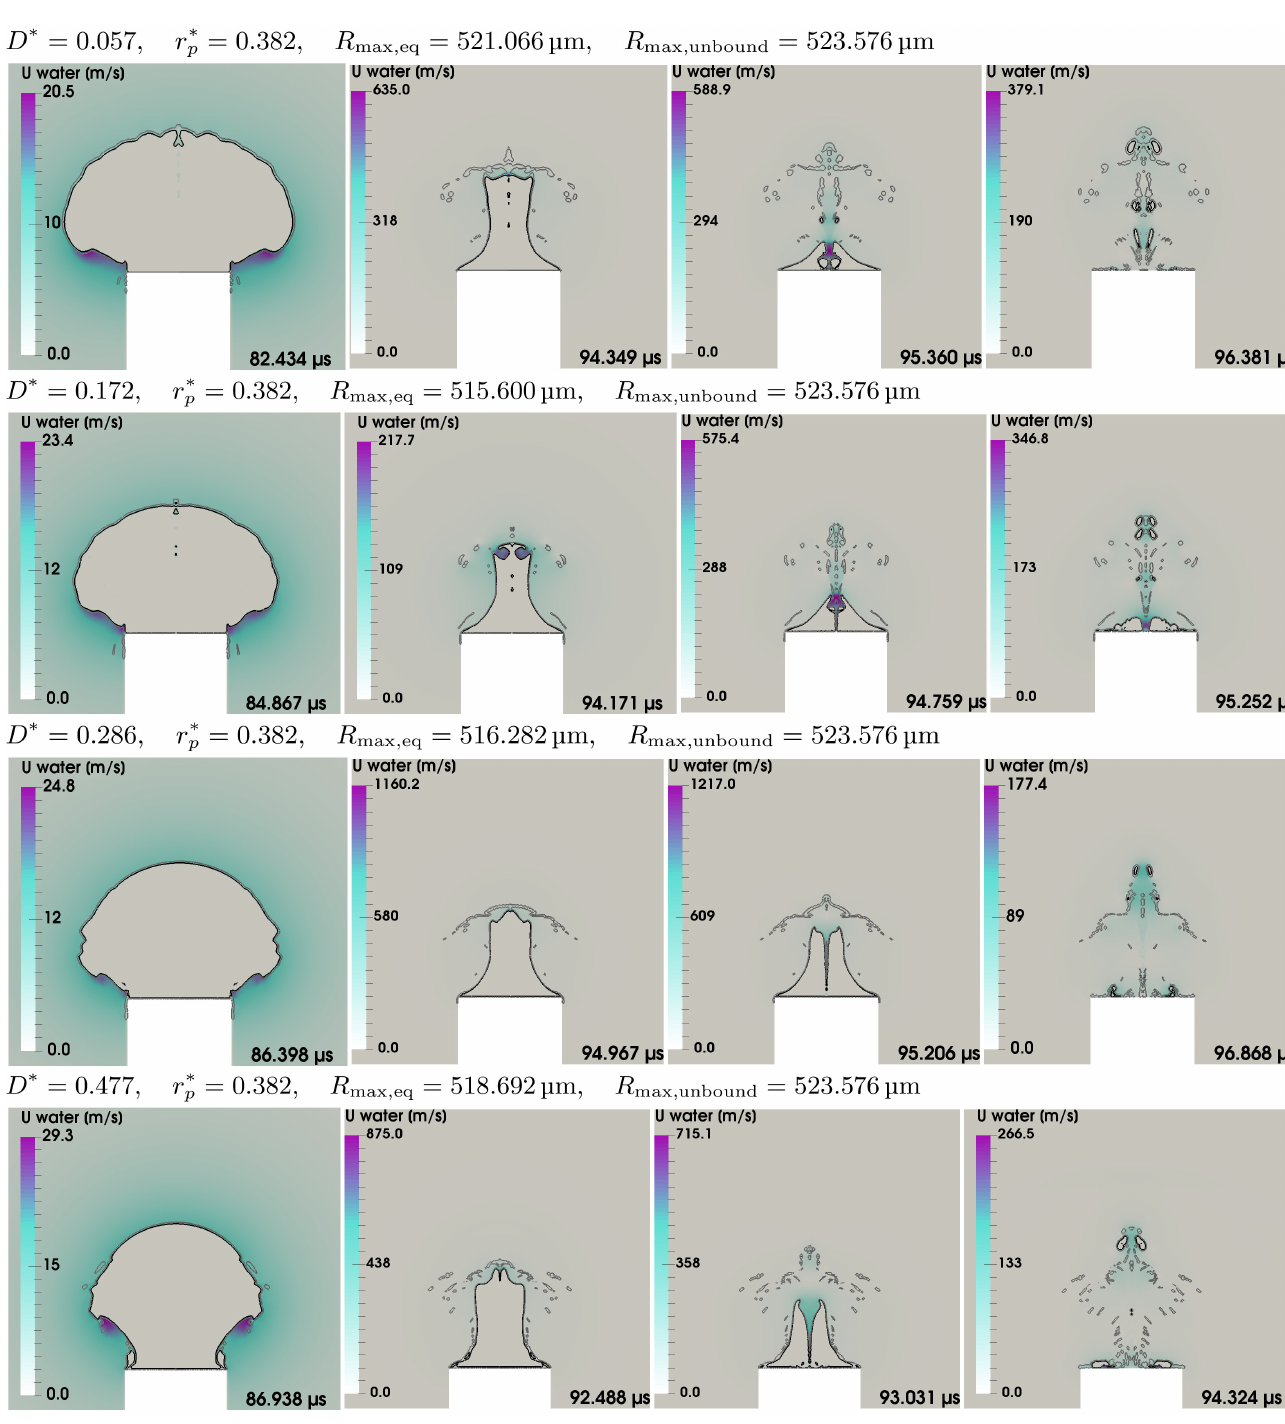
Figure A3. Mushroom bubble at r ∗ p = 0.382 for four different normalized distances D ∗ with the same R max,unbound . Cylinder radius is 200µm. Less overlap than in Figure